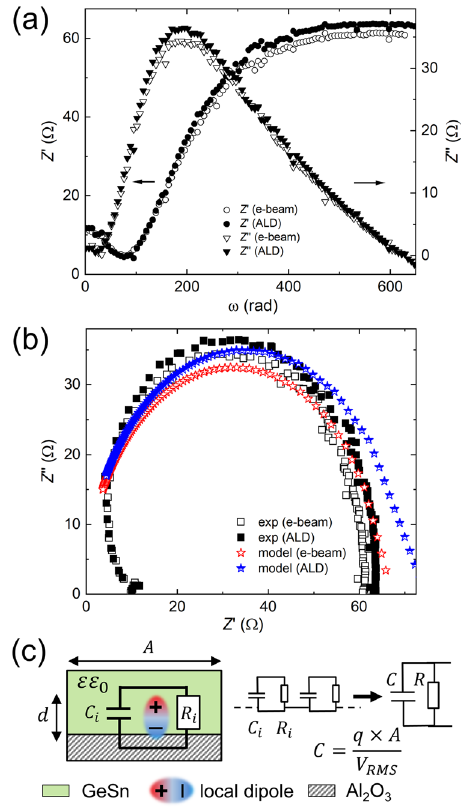
Fig. 7 Impedance measurements of the GeSn bilayer. Complex impedance of the GeSn bilayer in the frequency range f = 1 − 100 Hz. Open symbols refer to GeSn bilayer grown by e-beam method, while closed symbols denote those produced by ALD. a Real and imaginary parts of the complex impedance Z 0 (circles) and Z ″ (triangles) as a function of frequency ω = 2 π f. b Nyquist plot: experimental values of Z ″ plotted against Z 0 (squares); Z ″ and Z 0 determined from the RC model (stars). c Schematic representation for the local dipole and charge density q formation at the GeSn bilayer to Al 2 O 3 interface. The sum contribution of the local dipoles may be modelled as a parallel RC